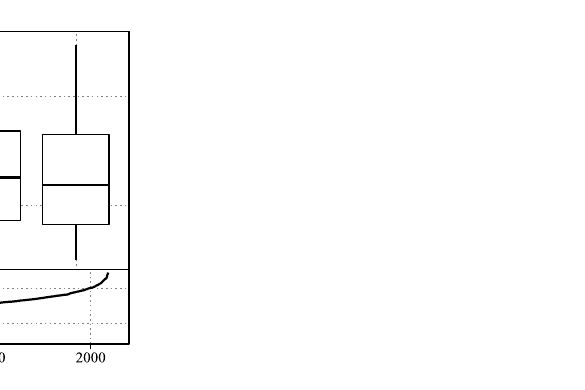
Figure 8. ( a ) The scatterplot for parameter a and c . ( b ) Complementary Cumulative Distribution Function (CCDF) of the number of retweets of original tweets. The approximate straight line on a single-log plot indicates the possibility of an exponential distribution.